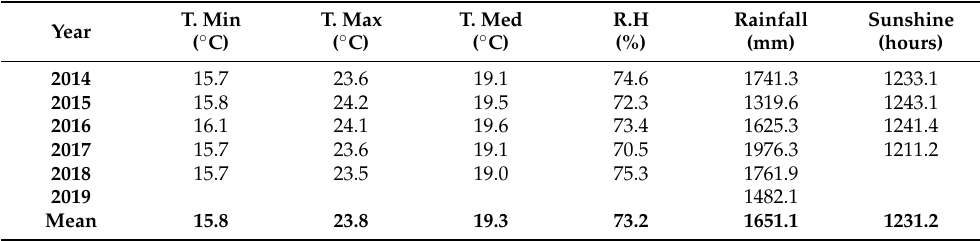
Table 1. Climatic conditions obtained from the weather station. Simon Campos weather